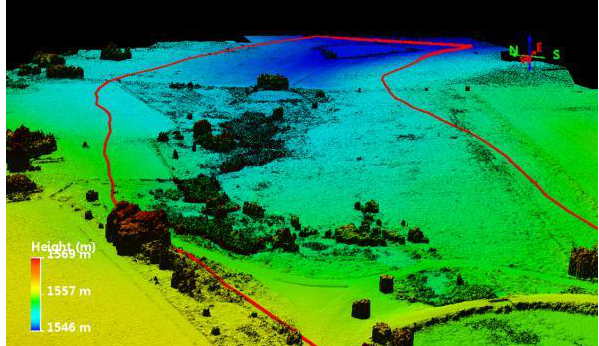
Figure 8. The DEM (0.038 m) with a visual overview of the UAV delineation and the location of some of the dams and roads and the interruption these features may cause.